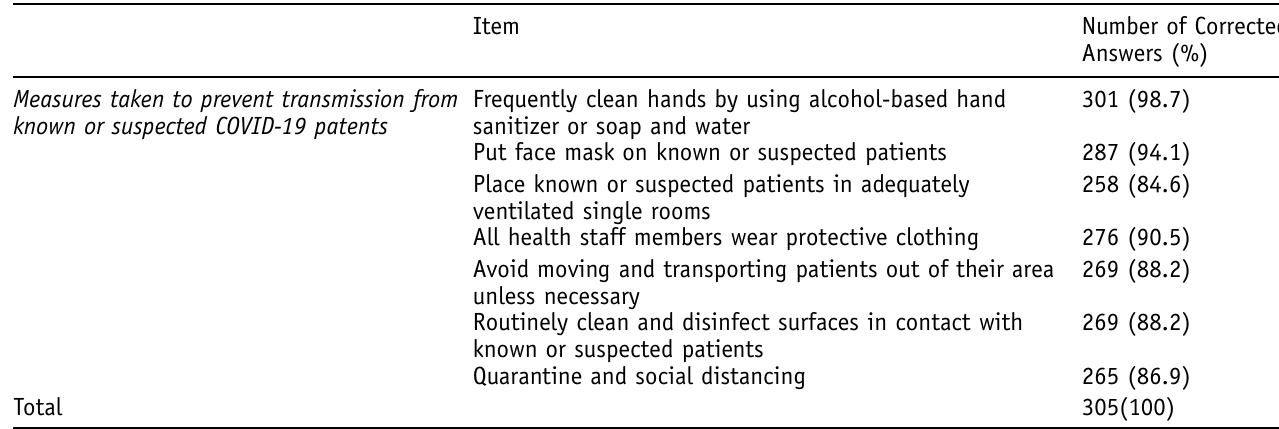
Table III. Knowledge (cid:1) students awareness about different COVID-19 transmission preventive